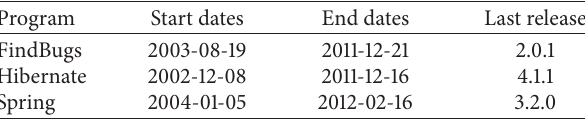
Table 1: Descriptive information for subject projects.